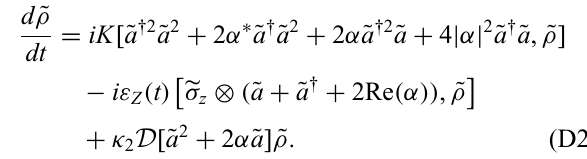
the actual function ln ((cid:10)